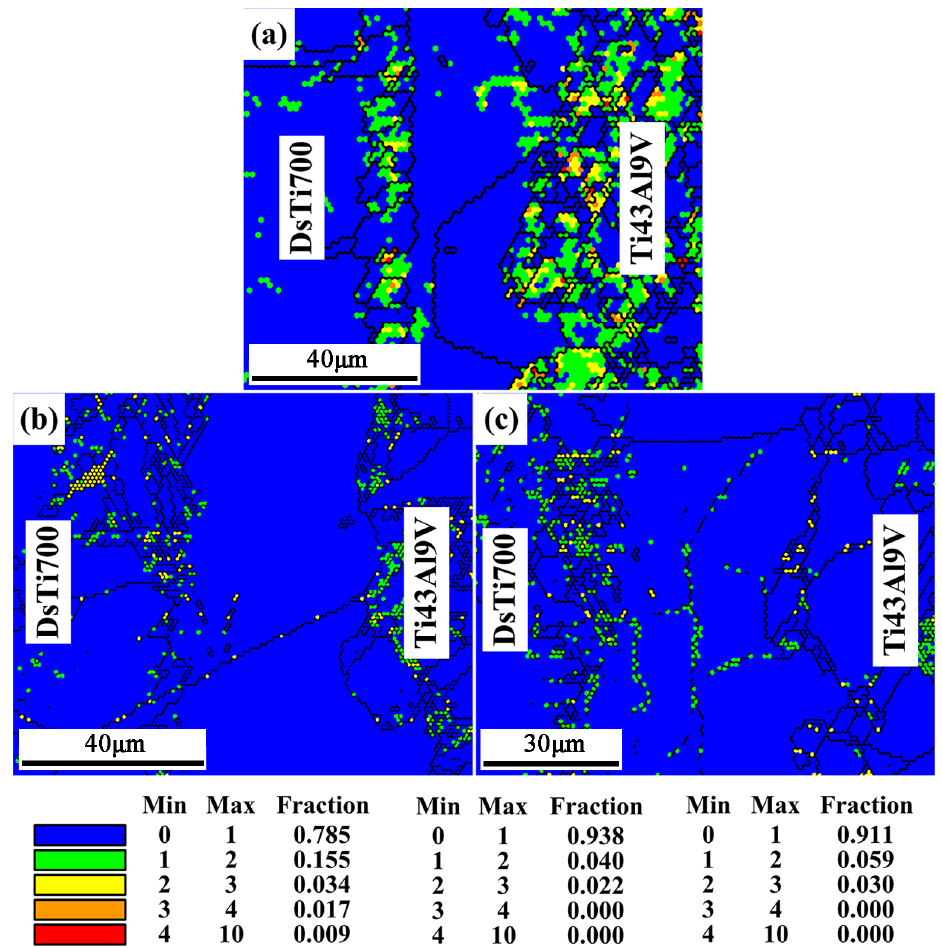
Figure 4. KAM analysis of the initial and heat-treated interfacial regions: ( a ) initial interfacial region, ( b ) HT1 and ( c ) HT5.